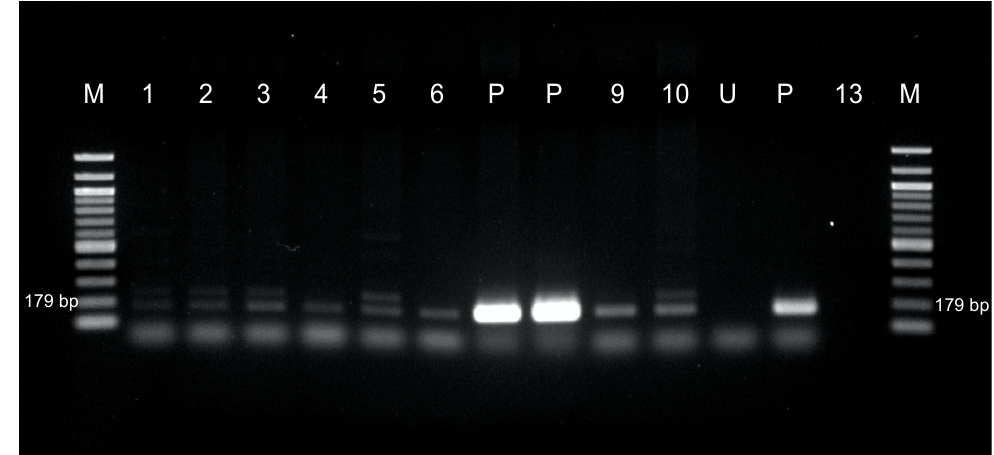
Figure 5. PCR analysis for the amplification of a specific 179 bp fragment of the OxO gene in American chestnut embryo lines transformed with p35S-OxO. Lanes 1, 2, 3, 4, 5, 6, 9, and 10—transformed events derived from embryogenic line TG; Lanes P—OV12, OV6, and T2 020, respectively (positive controls for OxO ); Lane U—untransformed embryos (negative control), Lane 13—empty (no DNA negative control); and M—DNA ladder (100 bp).